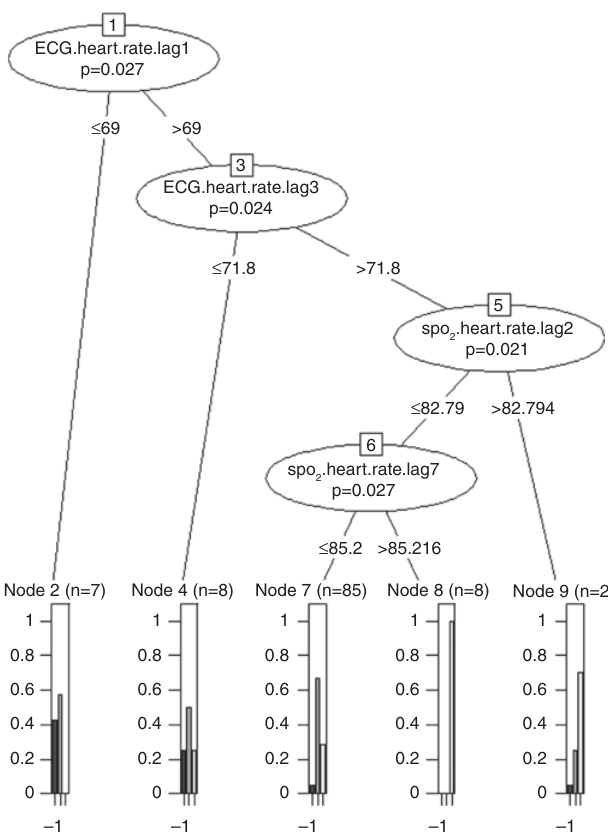
Figure 2: Classification Tree Using the Party Package in